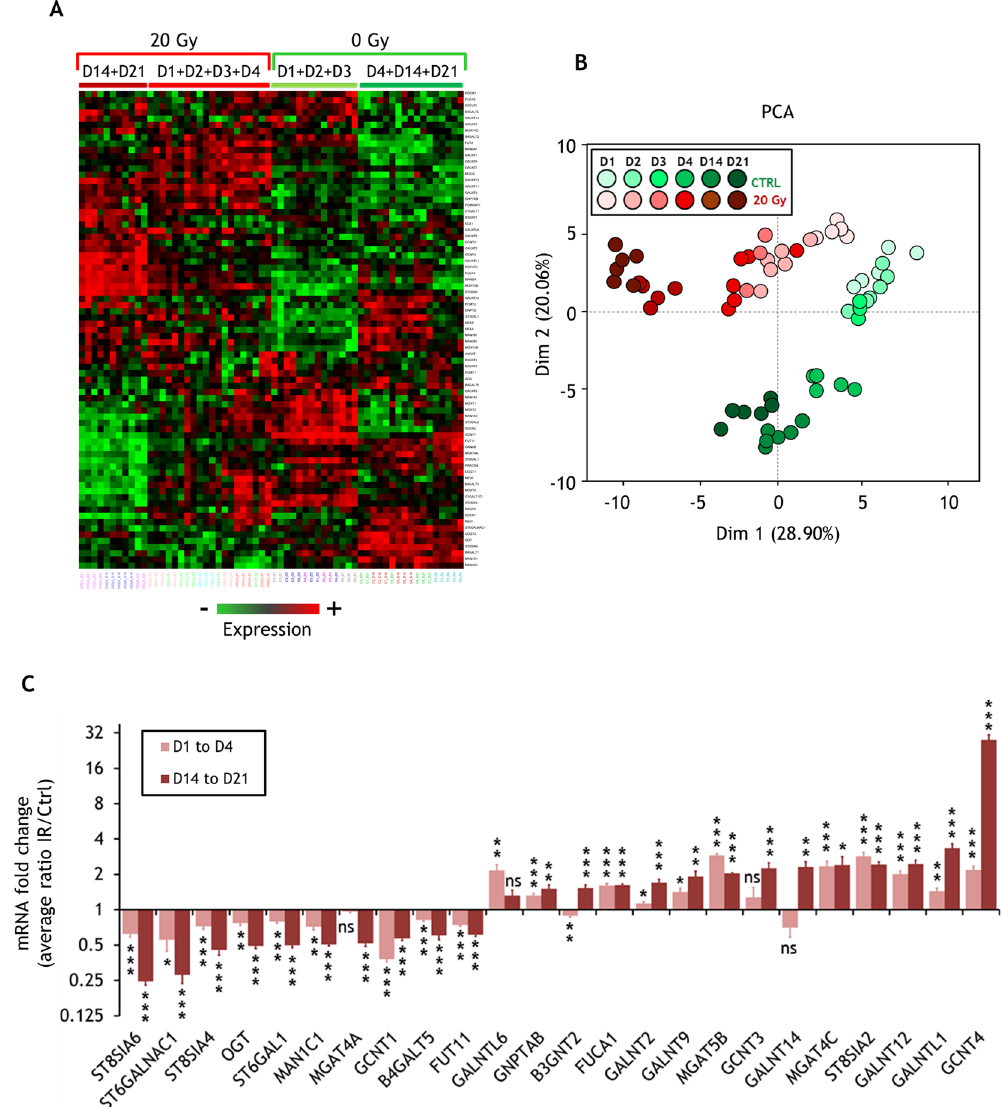
Figure 4. Glycosylation transcriptome analysis of irradiated HUVECs. ( A ) Heat map of the hierarchical clustering of all HUVEC samples based on measured gene expression values. ( B ) Principal component analysis of all HUVEC samples based on measured gene expression values. ( C ) Fold changes of statistically differentially expressed mRNA (24 genes) between control (0 Gy) and 20 Gy-irradiated HUVEC samples (fold change threshold 1.5) (mean + / − SEM, Log 2 scale). The experiment was replicated twice (two different cultures) with n = 3 repeated measures within the replications for each time point, except for day 3 which was performed once with n = 3 repeated measures. Data represent the mean of the two experiments. Hierarchical clustering and PCA were performed using all samples from the two experiments. The histogram was built from the two experiments and by grouping the data from D1 to D4 (with finally n = 19 for 0 Gy samples and n = 20 for 20 Gy samples), and from D14 to D21 (with finally n = 12 for 0 Gy samples and n = 11 for 20 Gy samples). Data were analyzed by a two-tailed t -test. Adjusted p -values (Benjamini-Hochberg procedure) (Ctrl vs IR): ns, non- significant (p ≥ 0.05); * p < 0.05; ** p < 0.01; *** p < 0.001. Ct, Δ Ct, 2 −Δ Ct , fold changes, SD, SEM and p -values are displayed in the Supplementary Table